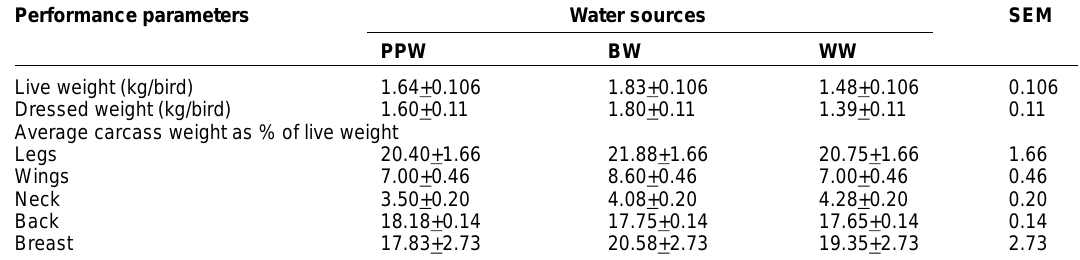
Table-4. Carcass characteristics of broiler chickens given different sources of water Performance